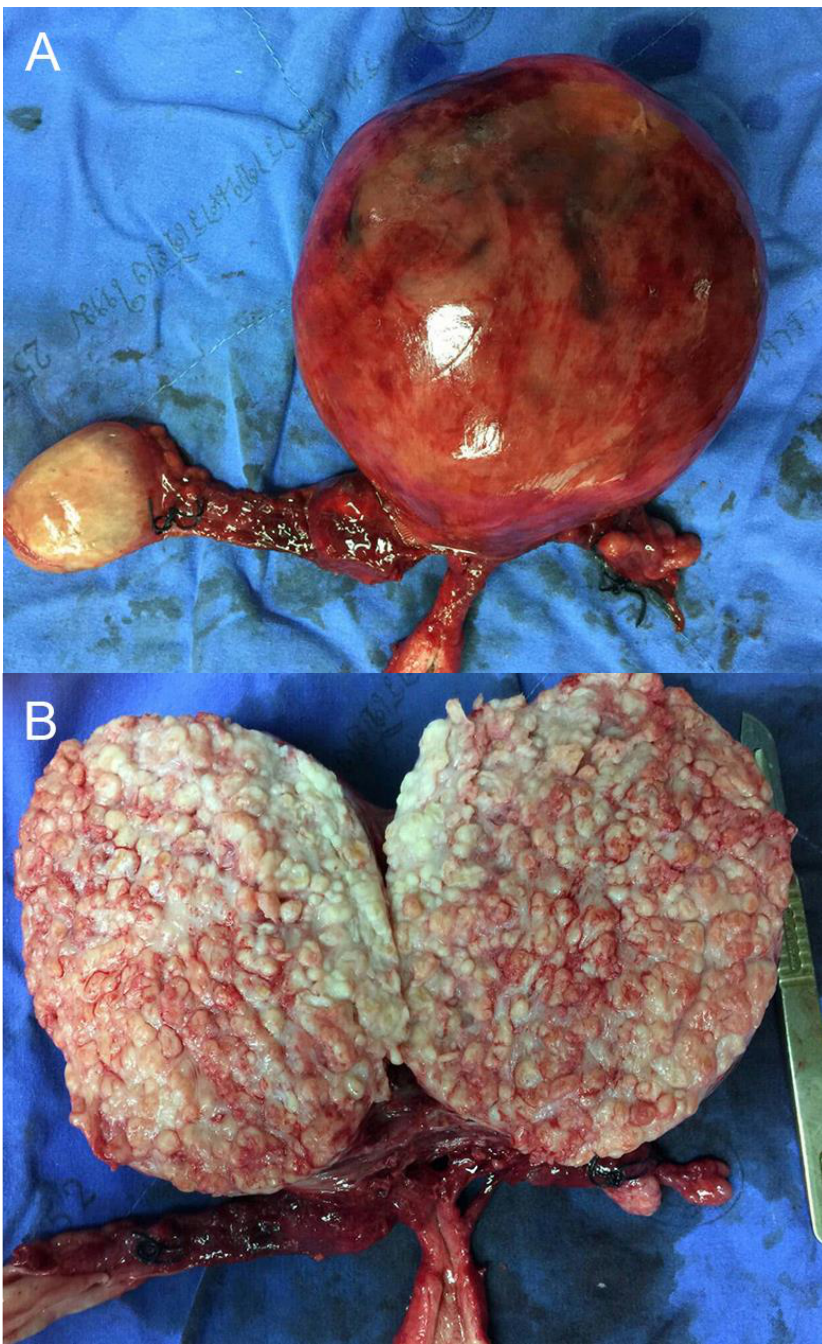
Figure 3. Total abdominal hysterectomy and bilateral salpingo-oophorectomy were performed. Post-operative findings: ( A ) The gross appearance of the sub-serous pedunculated leiomyoma; ( B ) The cut-surface of the mass showed numerous small discrete calcified pellets, which were densely packed all over the mass. The numerous calcified pellets are consistent with a scattered popcorn appearance on the imaging presented in Figure 1.